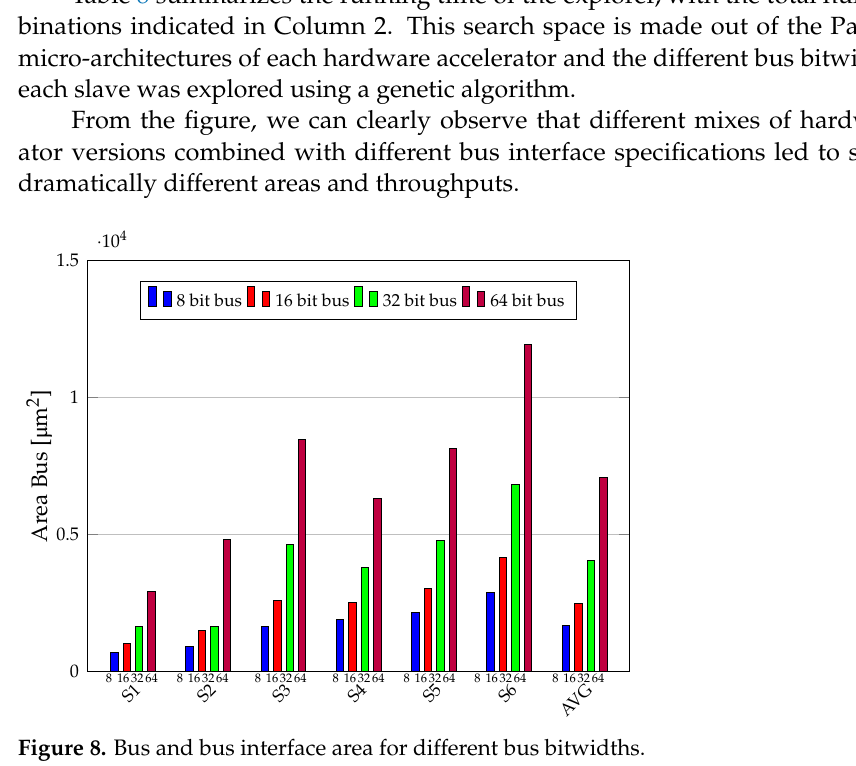
Figure 8. Bus and bus interface area for different bus bitwidths.